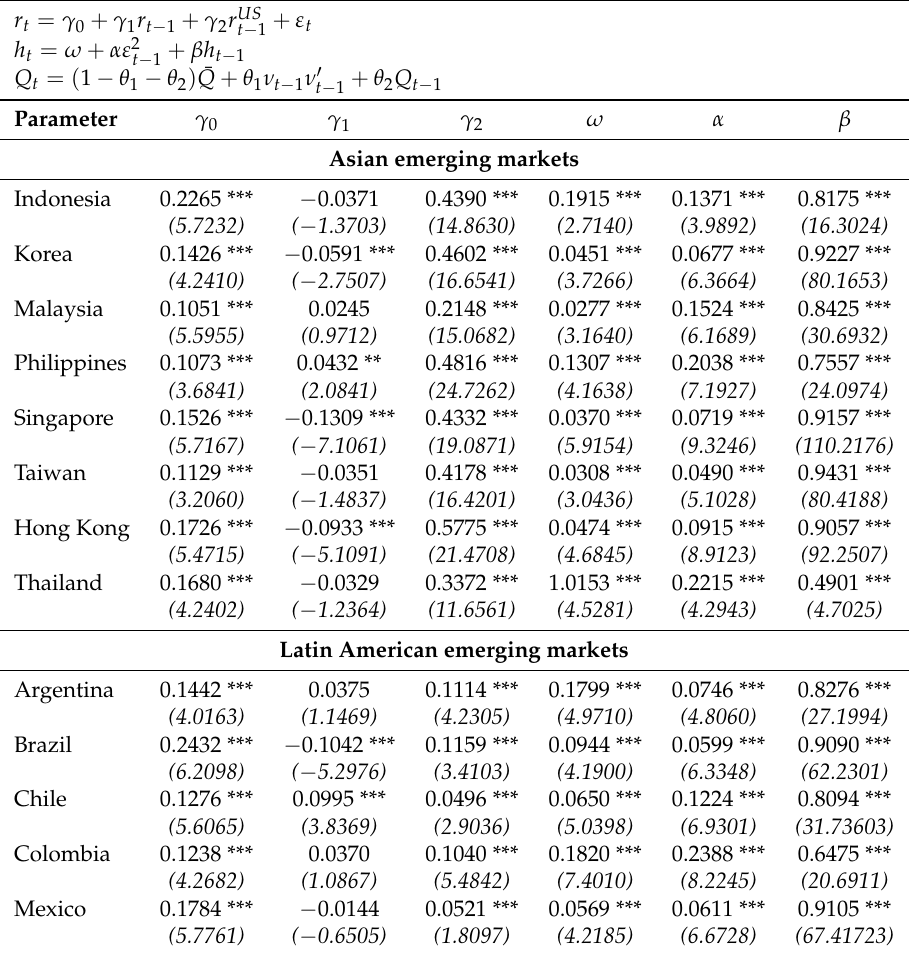
Table 7. Estimation of DCC-GARCH model for the US Subprime